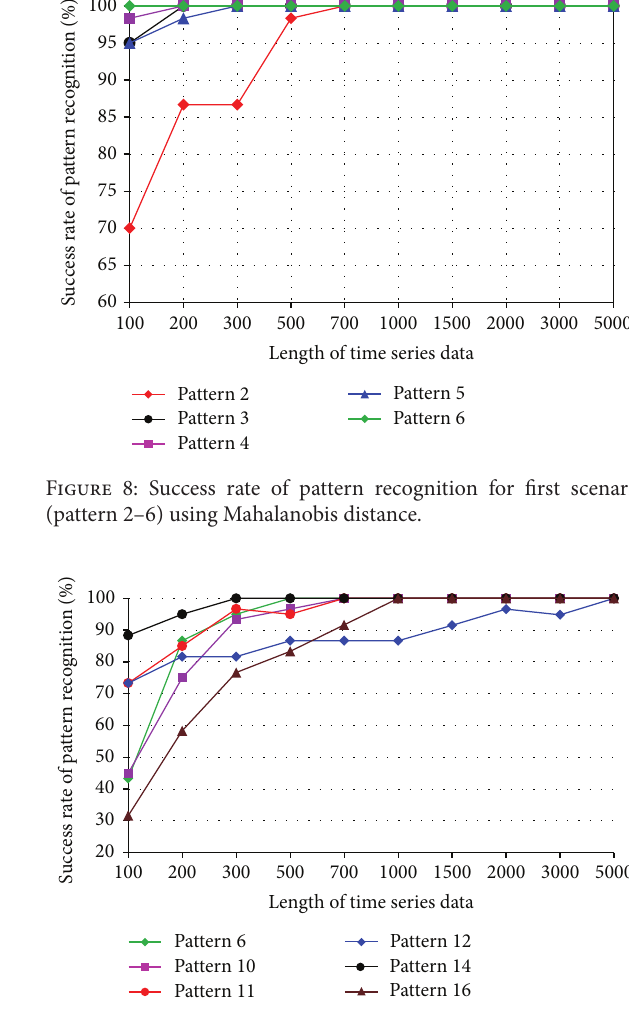
Figure 9: Success rate of pattern recognition for second scenario (patterns 6, 10, 11, 12, 14, and 16) using Mahalanobis